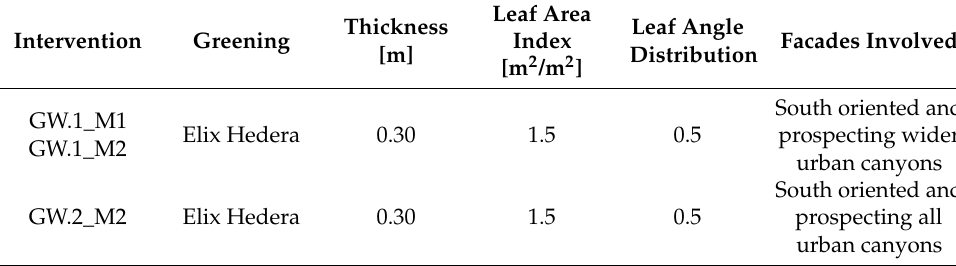
Table 8. Settings for the green walls retrofit (GW). Intervention Greening